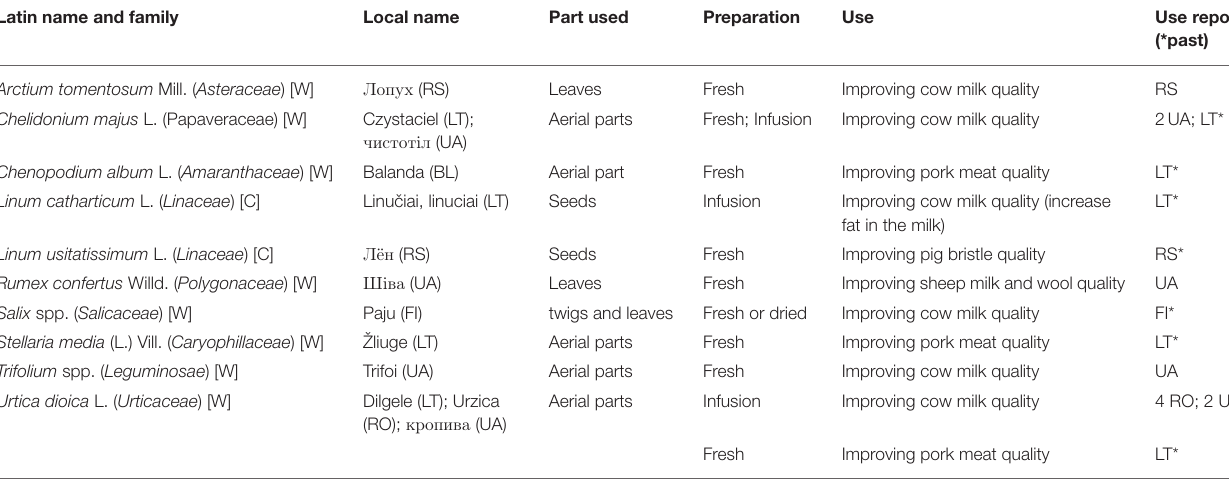
TABLE 2 | Plant taxa used for improving the technological quality of some animal products. Latin name and family